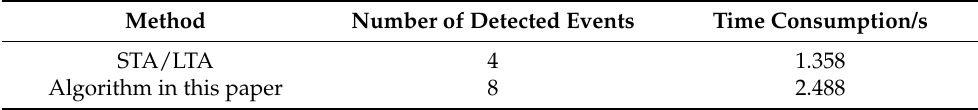
Table 1. Comparison of the method